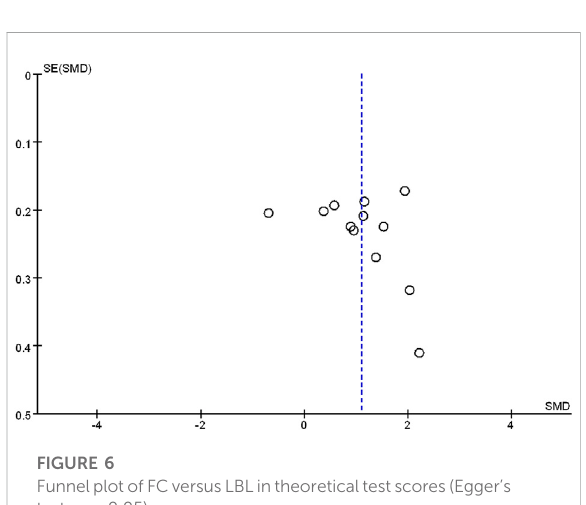
FIGURE 6 FunnelplotofFCversusLBLintheoreticaltestscores(Egger ’ s test, p > 0.05)